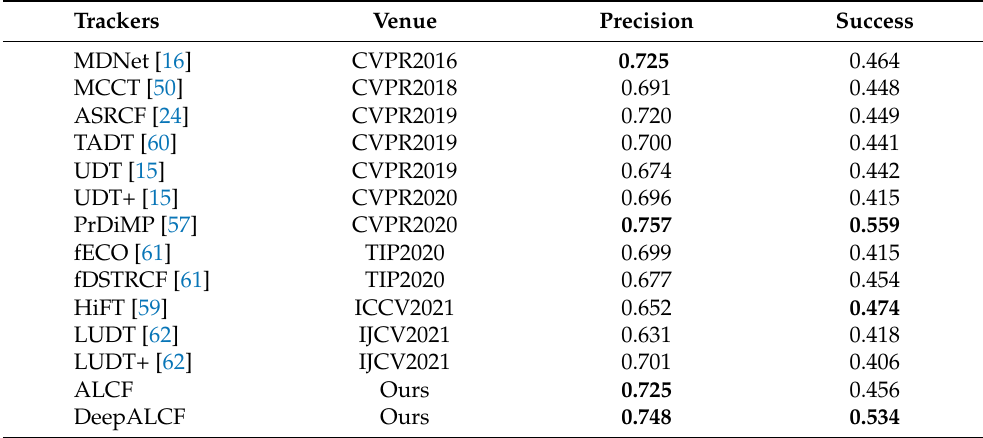
Table 4. Overall evaluation of ALCF, DeepALCF, and some other state-of-the-art trackers on UAVDT [39] (top 3 in bold